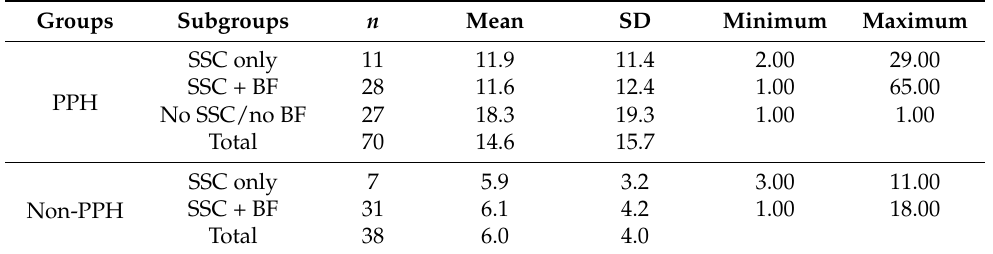
Table 4. Duration of Third Stage of Labor in Subgroups for Women with PPH and Women without